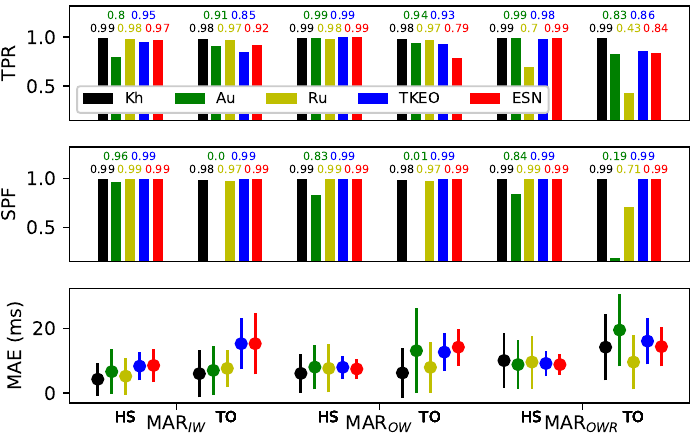
Figure 14. Comparison of the TKEO and ESN algorithms to other algorithms in terms of the TPR, the SPF and the mean (central point) and ± 1 standard deviation (error bar) of the MAE. The subsets MAR IW , MAR OW and MAR OWR of the MAREA database were used, as were the results of the Kh, Au and Ru algorithms from [15]. The performance criteria used here for TKEO and ESN were adjusted to match the criteria used for Kh, Au and Ru. A threshold of 40 ms was used to consider the events as TP. The MAE was evaluated with the error from the TP events only. The number of points in each timeseries was considered for a sampling rate of 128